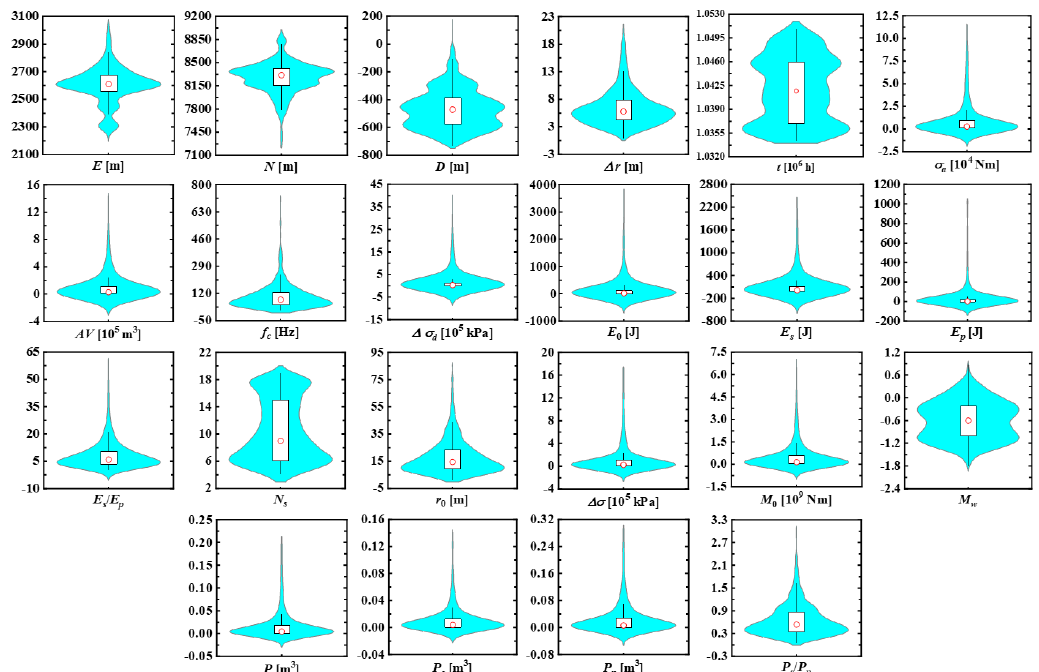
Figure 3. Violin plots of the distribution of the 22 seismic parameters in the sample dataset. The box in each plot indicates the lower (Q1) and upper (Q3 ) quartiles, and the red circle indicates the median value. The value of Q3 minus Q1 is defined as the interquartile range (IQR ). The range of whiskers at both ends of the box represents the upper and lower bounds, which are defined as Q3 + 1.5 ∗ IQR and Q1 − 1.5 ∗ IQR, respectively. Cyan represents the distribution of data points.